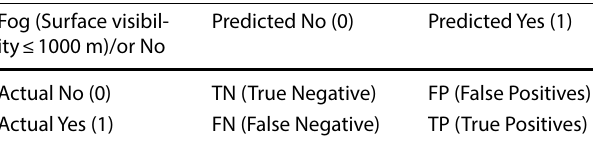
Table 1 Model contingency table for computation of forecast qual-